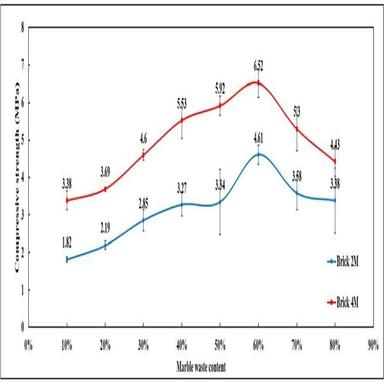
Compressive strength of hybrid geopolymeric composite samples prepared at different molarities and marble waste content.